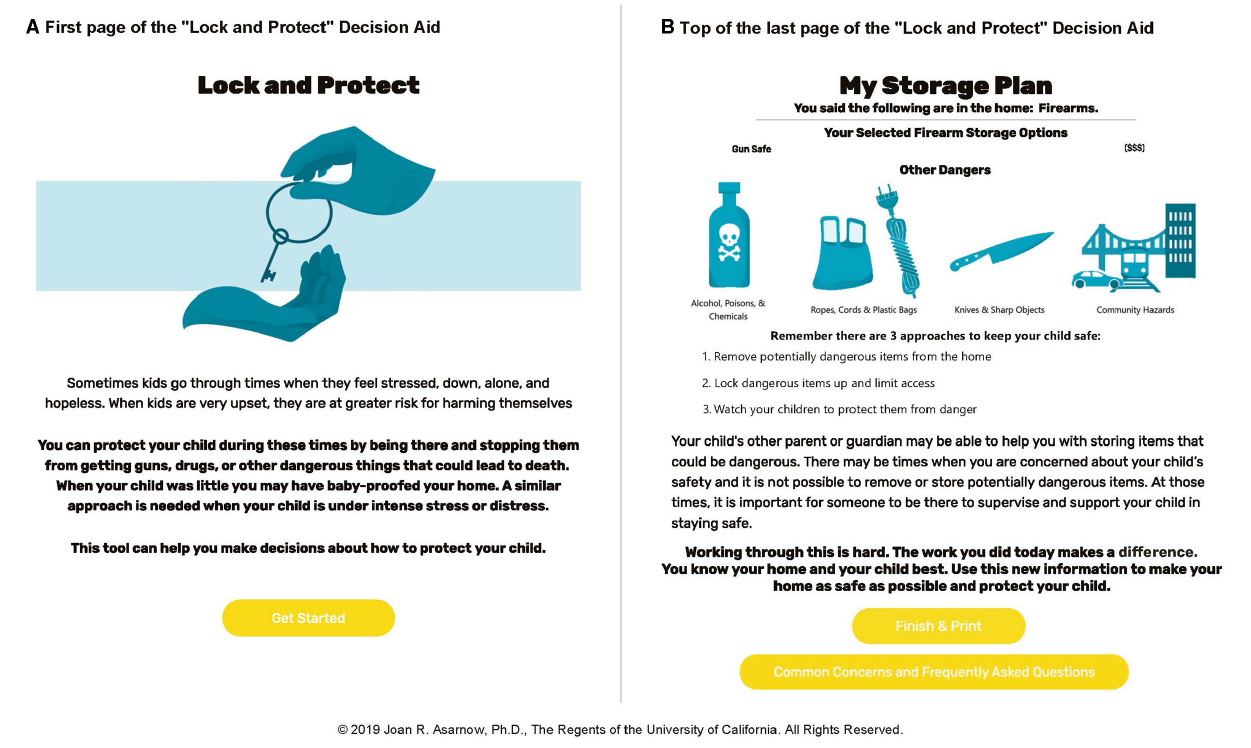
FIGURE 1 | Screenshots from “Lock and Protect” Decision Aid: (A) First page of the “Lock and Protect” Decision Aid. (B) Top of the last page of the “Lock and Protect” Decision